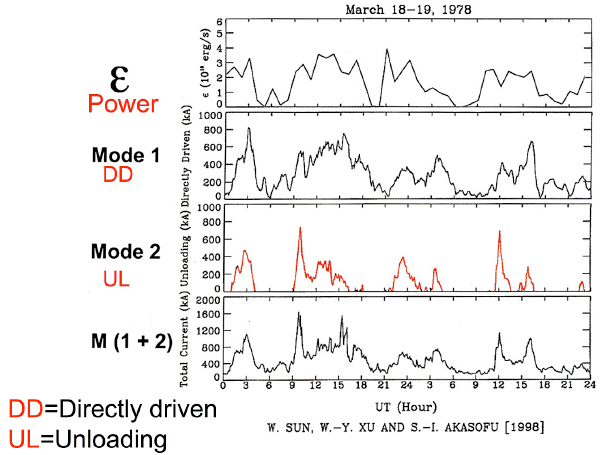
Fig. 4. From the top, the solar wind-magnetosphere dynamo power ε , the DD two-cell current intensity (Mode 1), the substorm (UL) current (Mode 2) and the combination of Mode 1 and Mode 2 (cor- responding to an improved AE index, because the total current in- tensity is